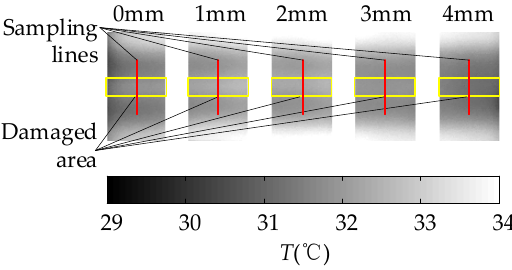
Figure 16. The thermal image of 30 s of the MFI thermal excitation.